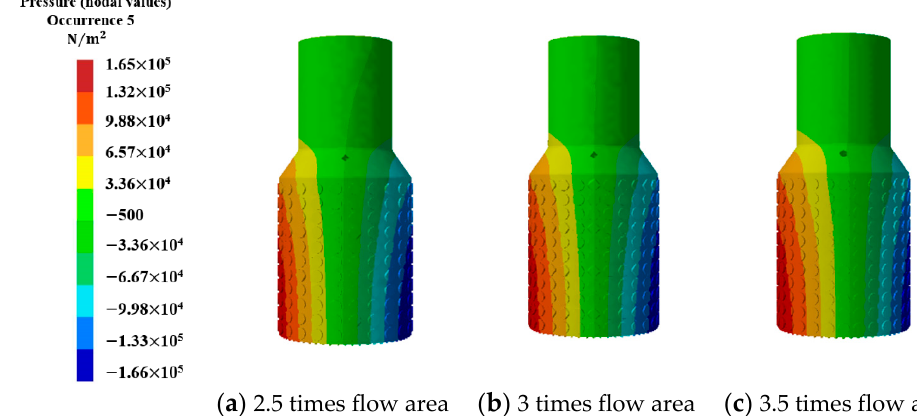
Figure 24. Fifth-order acoustic cavity modality.